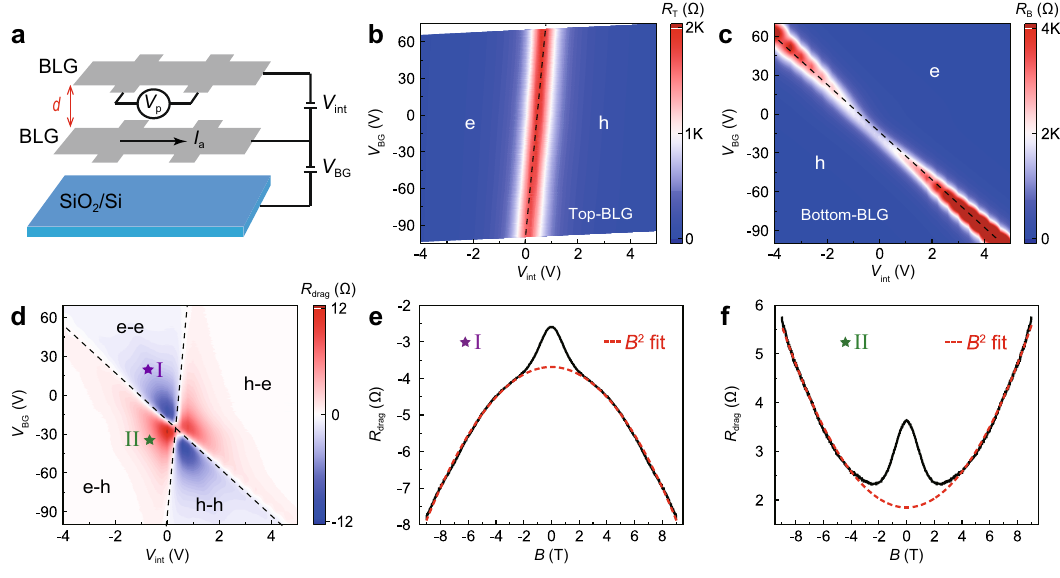
Fig. 1 | Typical drag behaviors in the bilayer/bilayer graphene (BLG/BLG) device.a Schematicofthedragset-upfortheBLG/BLGdevice.Thetopandbottom BLGlayersareseparatedbyhBNlayerwiththethickness d ~11.3nm. b , c Resistances of top BLG layer ( R T ) and bottom BLG layer ( R B ) as functions of V int and V BG , respectively. d Drag resistance ( R drag ) as a function of V int and V BG . Dashed lines